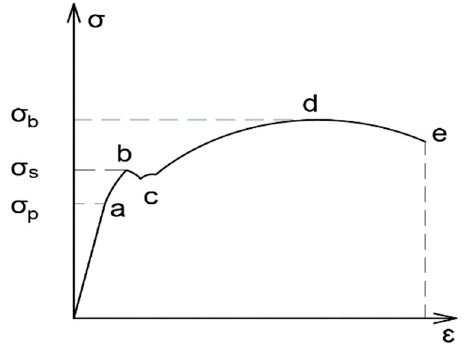
Figure 6. Failure process for nonideal plastic materials.